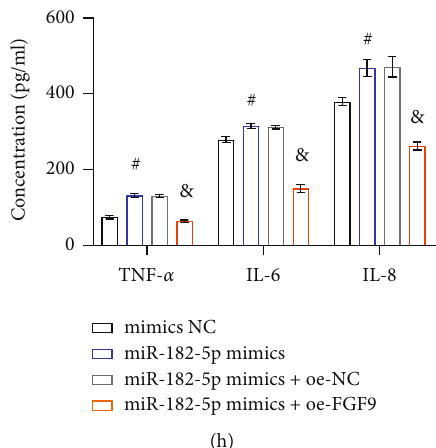
Figure 5: miR-182-5p targeting FGF9 inhibited chondrocyte proliferation and promoted apoptosis. The gene expression of (a) miR-182-5p and (b) FGF9. (c) The protein expression of FGF9. (d) Cell viability was monitored by CCK8. (e) Plate cloning of cells. The (f) cell cycle and (g) apoptosis was captured by fl ow cytometry. (h) The expression of in fl ammatory factors (TNF- α , IL-6, and IL-8) was evaluated by ELISA. # P < 0 : 05 vs. mimics NC. & P < 0 : 05 vs. miR-182-5p mimics